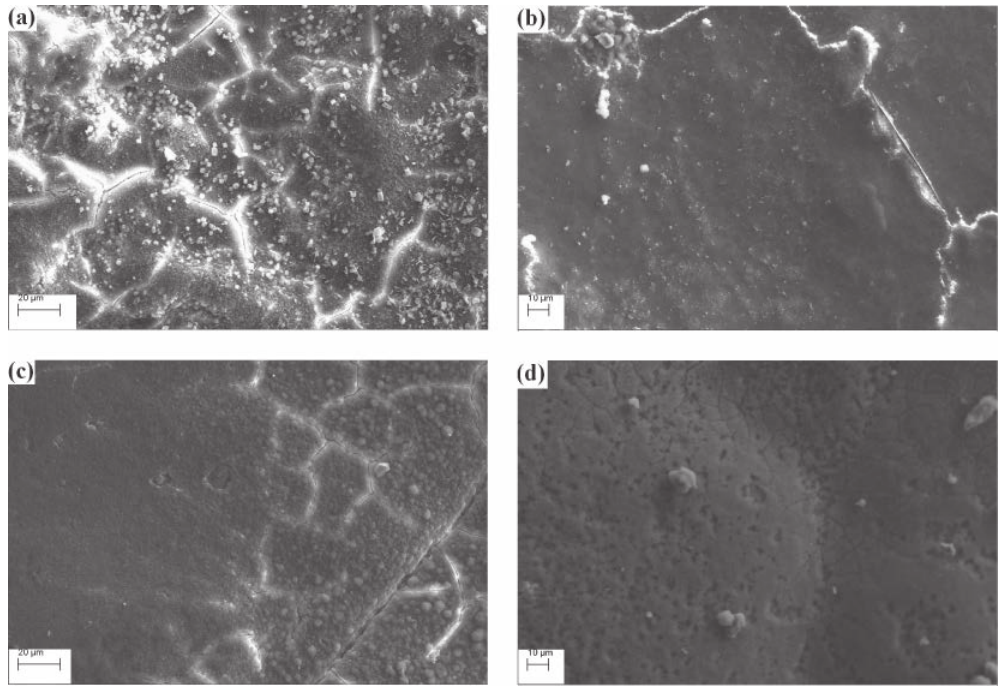
Fig. 5: SEM of the surface of h -BN under different H 2 O/air mass ratio conditions at 1273 K for 18 h: (a) 1.5:100, (b) 3.5:100, (c) 5:100, (d) 6.5:100.